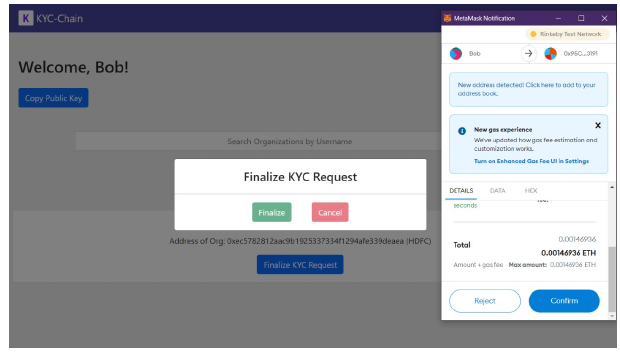
Fig. 8 . Organization’s view of finalizing client requests